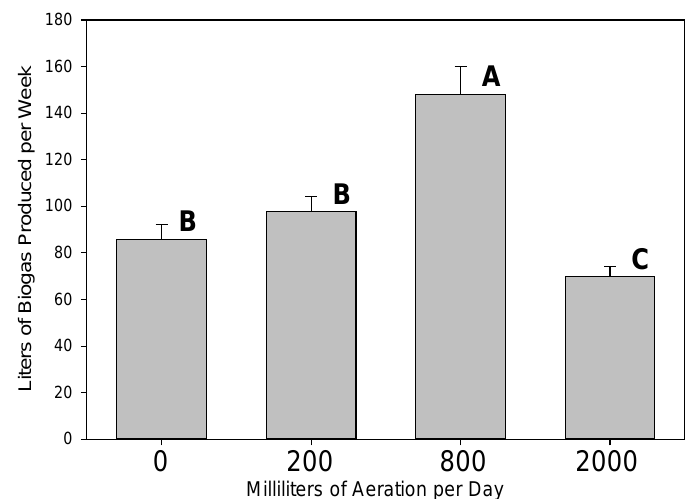
Figure 2. Average weekly gas production by digesters from week three onwards. Bars represent the mean of 18 determinations ± standard error of the mean. Bars labeled by the same letter are not significantly different by a Duncan’s multiple range test.